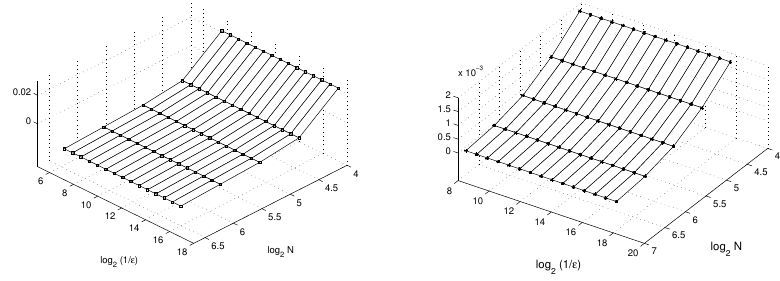
Figure 7. Surface plot of the maximum pointwise errors as a function of N and ε for the scaled discrete derivative components εD 0 Y 1 and εD 0 Y 2 using HDS - I for the Example 2.